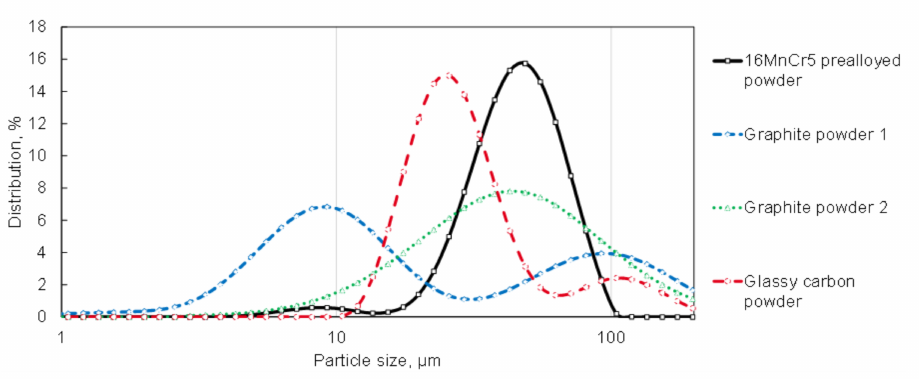
Figure 2. Particle size distribution of the powders used showing a narrow distribution of the glassy carbon powder.